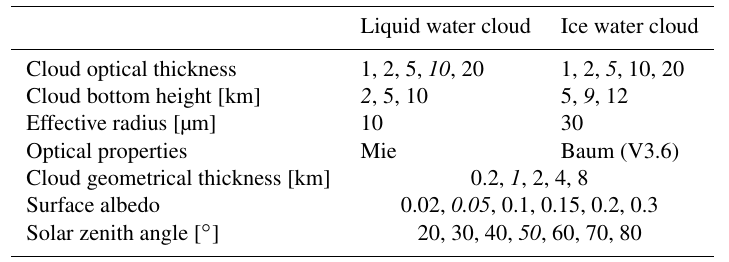
Table 1. Settings for the box cloud simulations. Numbers in italics indicate the base cases. For surface albedo, solar zenith angles and cloud geometrical thickness, the same settings were used for liquid and ice water clouds.